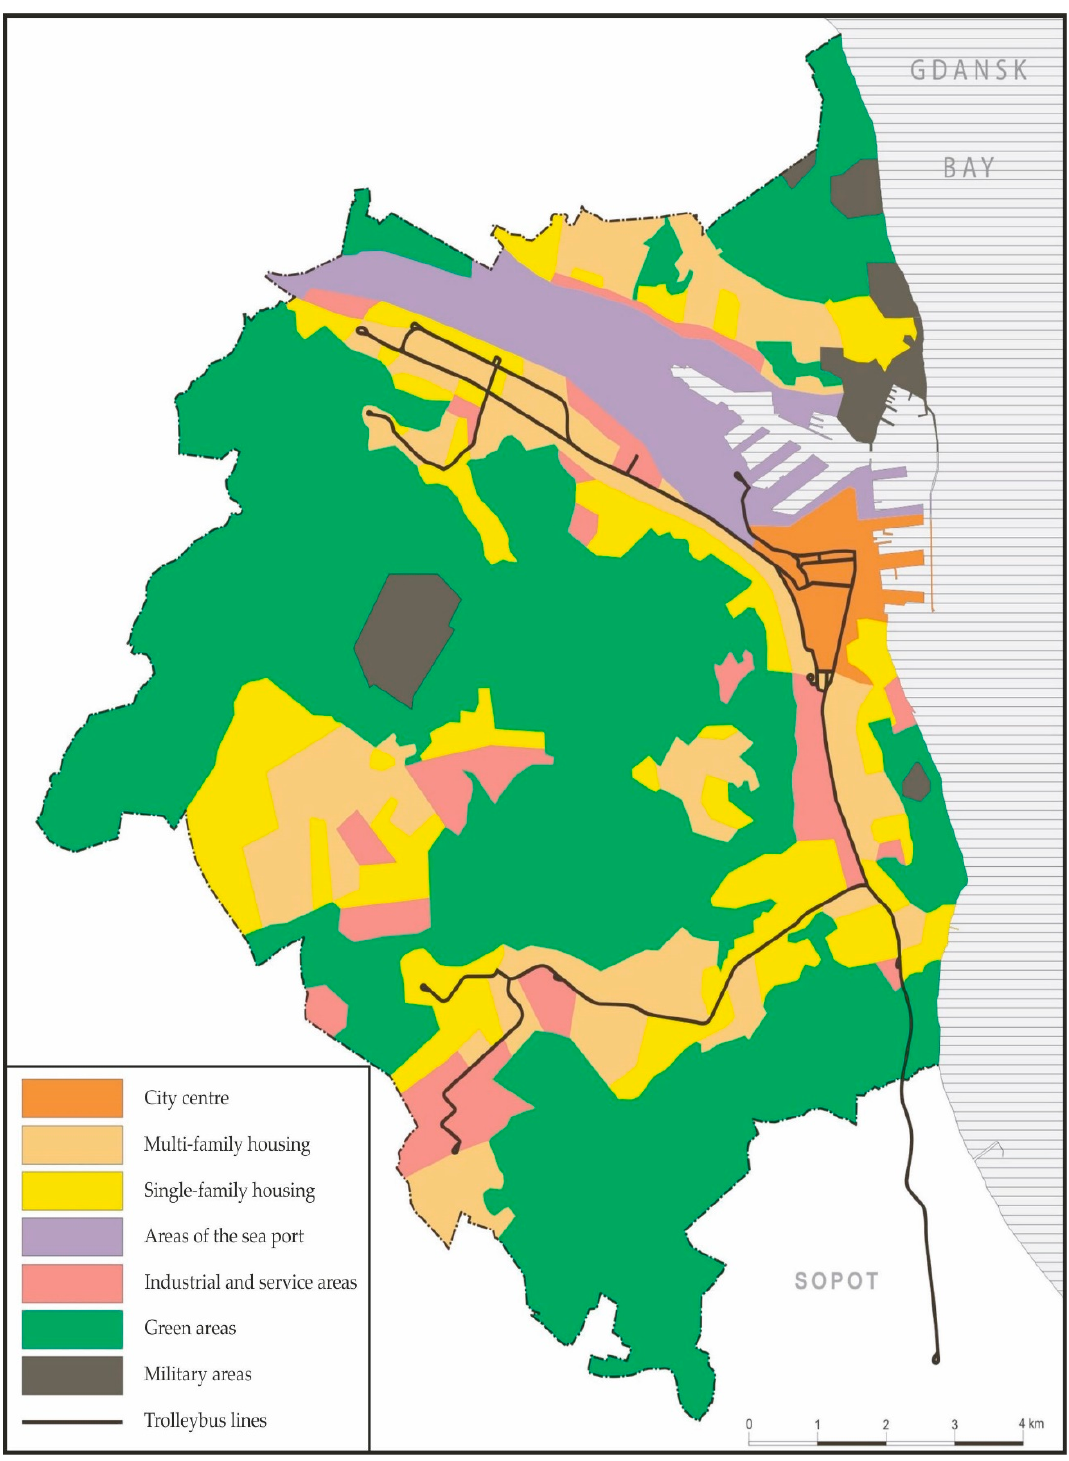
Figure 5. Trolleybus transport network in Gdynia in the context of the functional and spatial structure of the city (source: own elaboration).